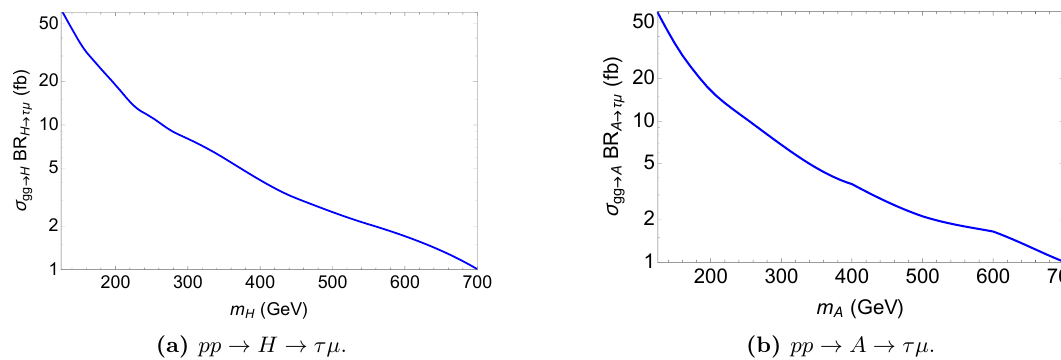
Figure 13. The estimated 95% C.L. bounds for the scalar (left) and pseudoscalar (right) decaying into tau and muon at the 13 TeV LHC with 300 fb (cid:0) 1